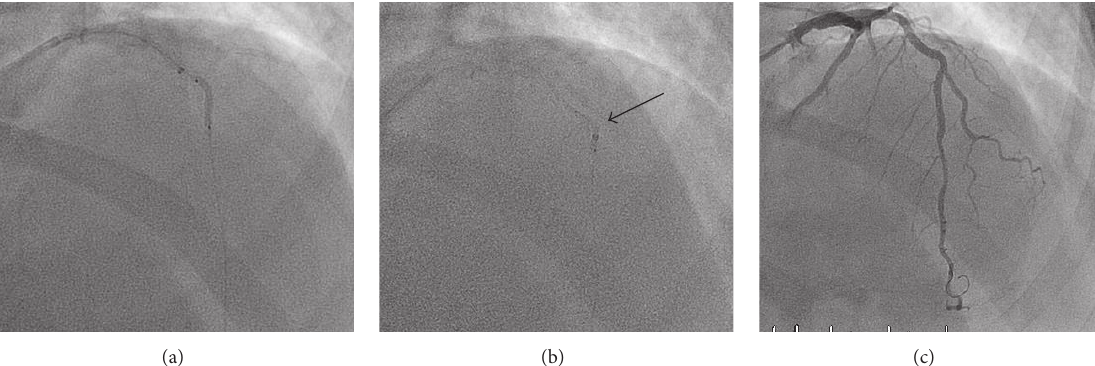
Figure 3: Successful PCI of LAD after using GBAT technique. (a) Predilation of the lesion with a 2.0 × 15 mm noncompliant balloon. (b) Successful advancement of the GuideLiner across the lesion with an inflated balloon at the tip; the black arrow refers to the GuideLiner with the protruding compliant balloon. (c) Successful stent delivery and PCI of the proximal LAD.